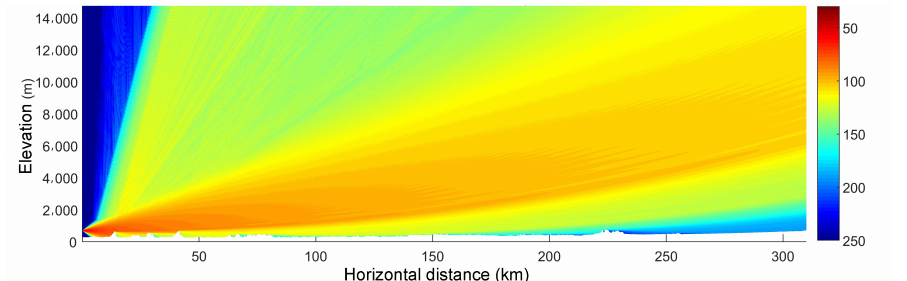
Figure 8. The electric field distribution in the longitudinal section of the entire troposphere in the calculation space with modified refractivity.